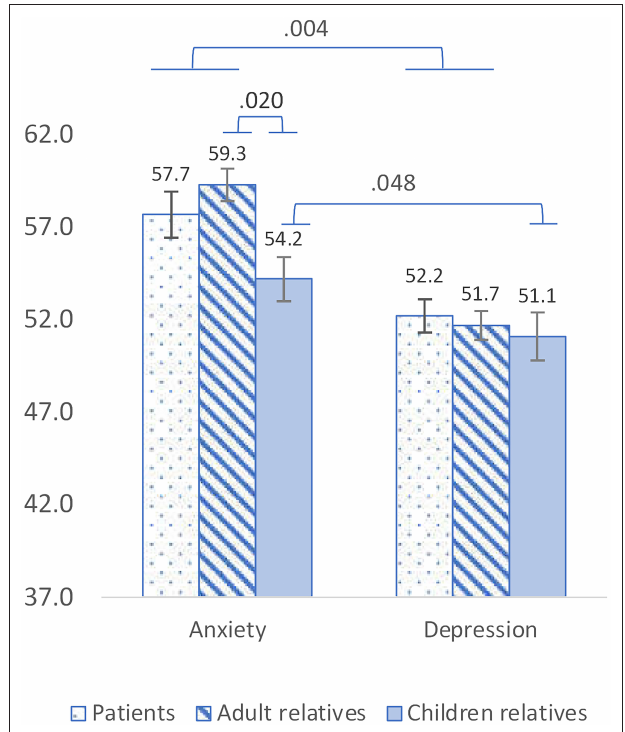
FIGURE 1 | PROMIS Anxiety and Depression mean scores among adult patients, adult relatives and relatives who are children. Anxiety was significantly higher than depression among adults [ F (1,177) = 8.40, p = 0.004] and among children [ F (1,30) = 4.23, p = 0.048]. Compared to adult relatives, relatives who are children reported significantly lower levels of anxiety [ F (1,122) = 5.59, p = 0.02] and similar levels of depression [ F (1,121) = 0.17, p = 0.67].